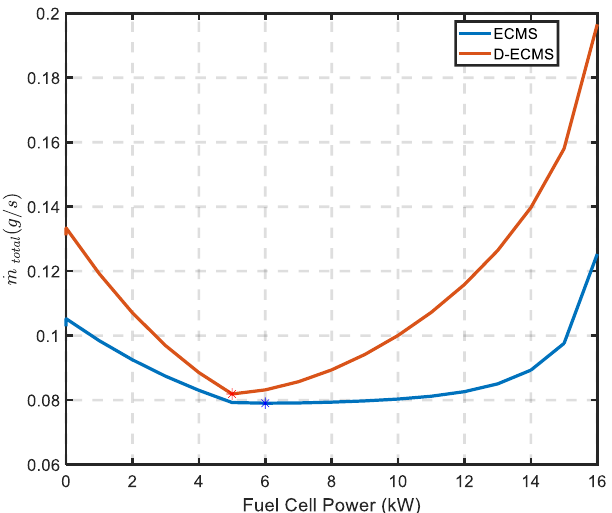
Figure 7. Illustration of the ECMS and D-ECMS algorithm operation at power demand of 6 kW and 60% SOC.